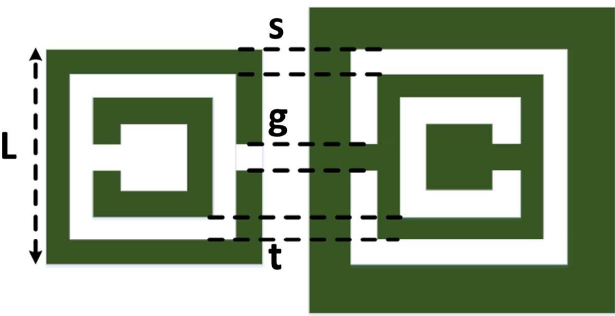
Figure 2. The geometry of a CSRR and SRR, where L = 3 mm, g = 0 . 2 mm, s = 0 . 2 mm and t = 0 . 2